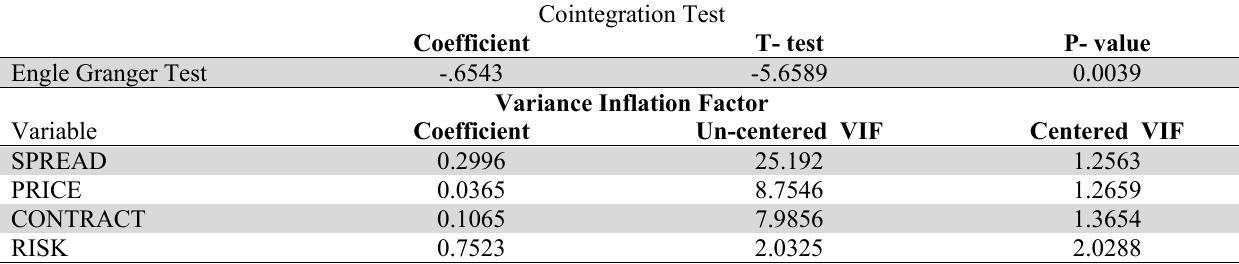
Engle-Granger Test (Co-Integration Test) and VIF